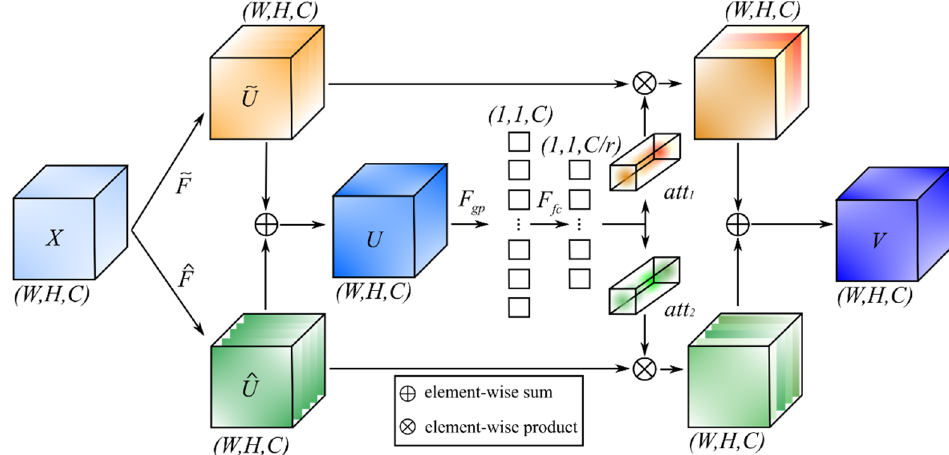
Figure 3. The proposed DSA module.